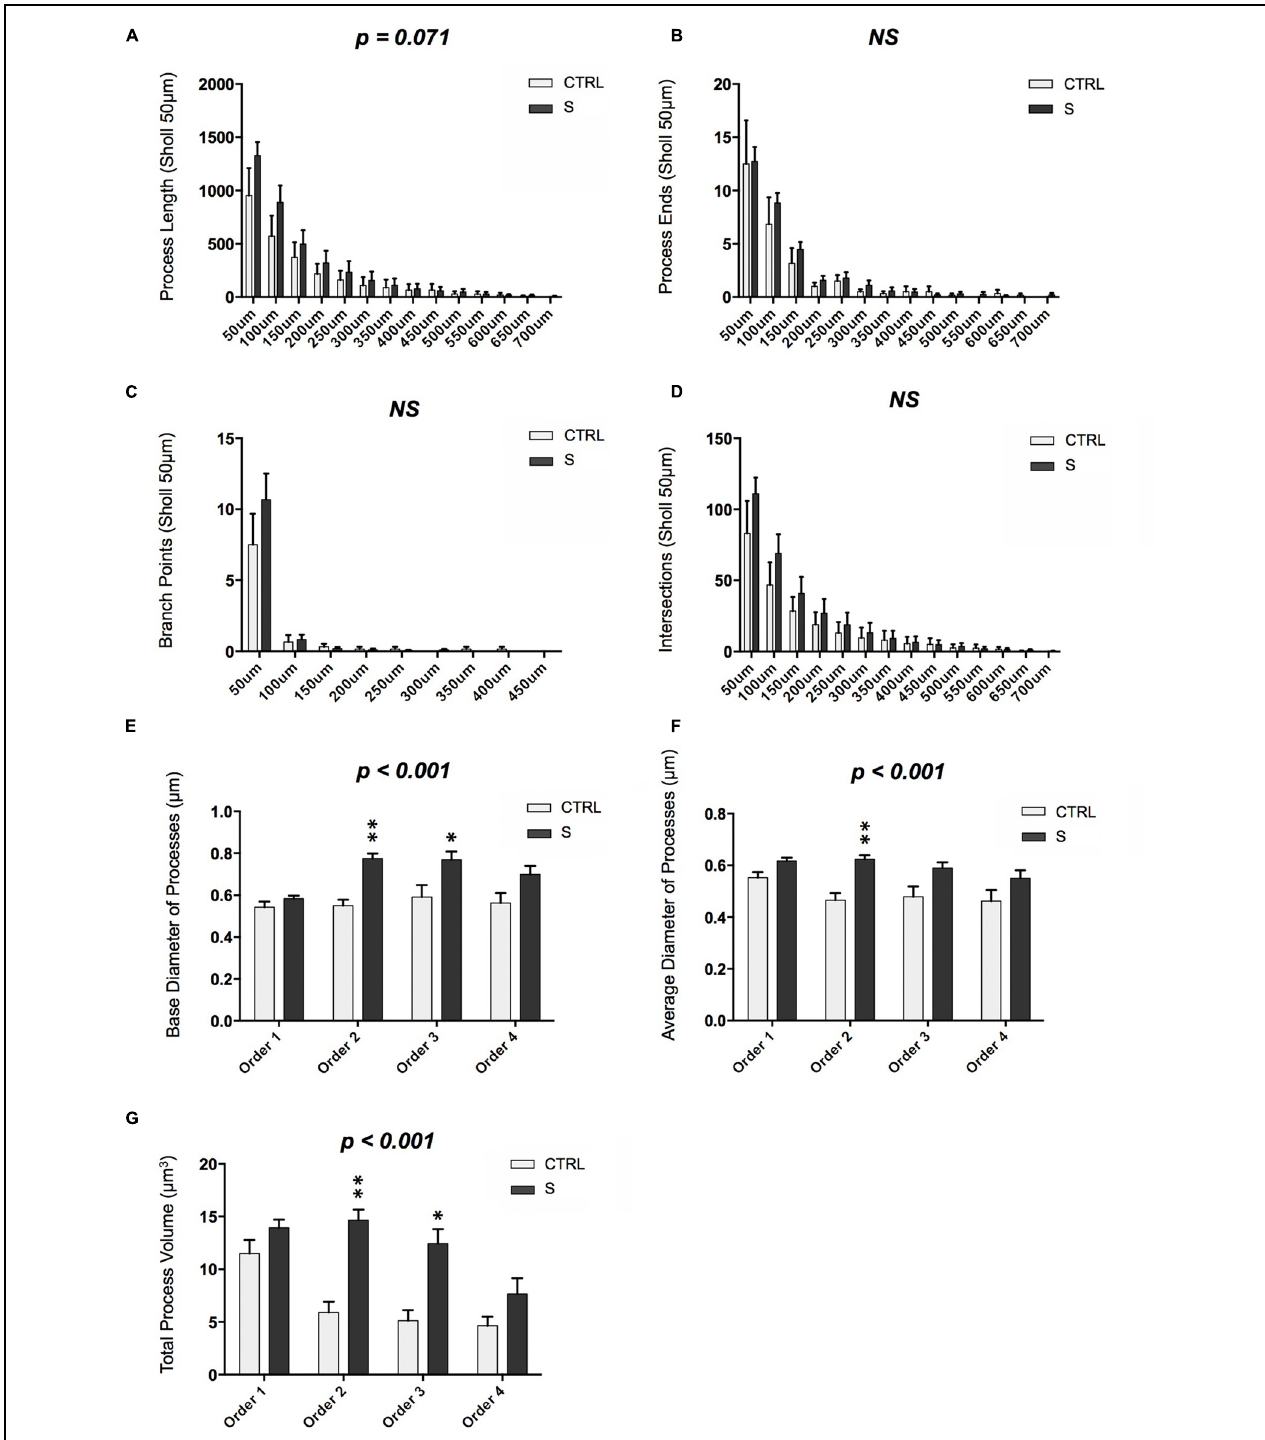
FIGURE 3 | Morphometric analysis of DCX-IR cells in the OT of suicides (S; n = 6 cells) and controls (CTRL; n = 19 cells). (A) DCX-IR cells in suicides showed a tendency toward increased process length as compared to CTRLs ( p = 0.071). (B–D) However, groups did not differ with regards to the number of process ends, branch points, or processes/Sholl intersections. (E,F) DCX-IR processes in suicides displayed significantly